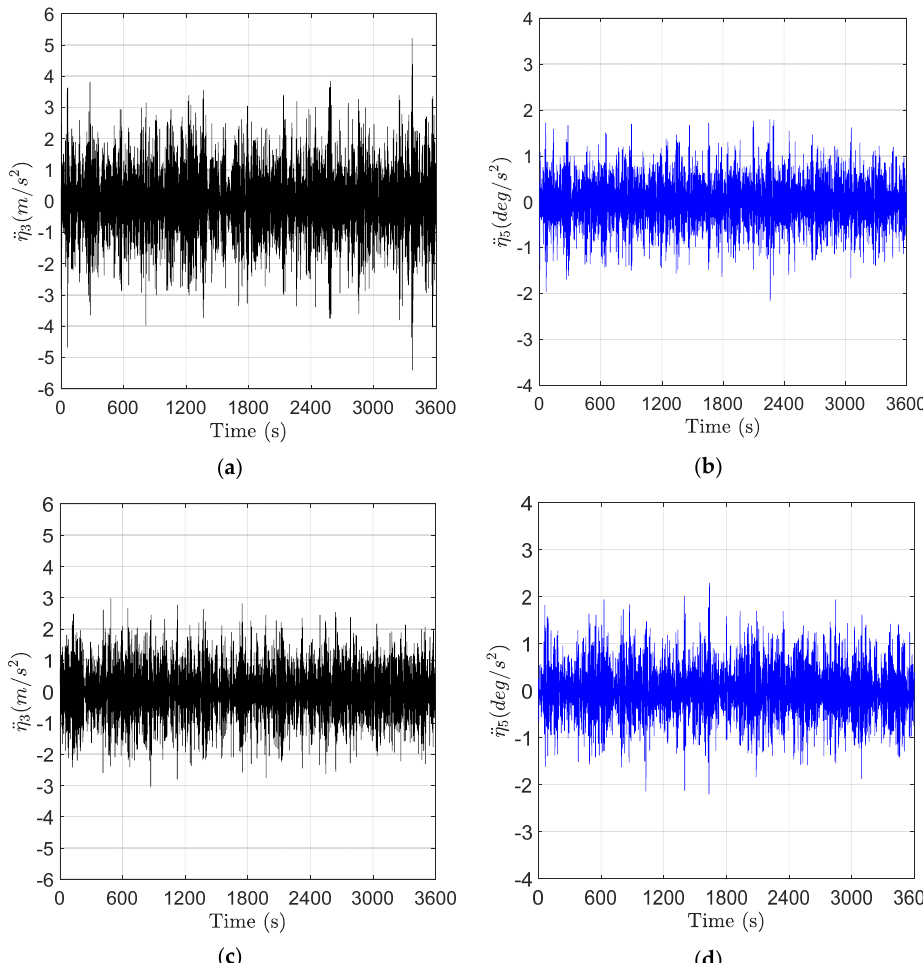
Figure 7. Data collection, accelerations amplitude: ( a ) Heave—7 January 2020; ( b ) Pitch—7 January 2020; ( c ) Heave—8 January 2020; ( d ) Pitch—8 January 2020.